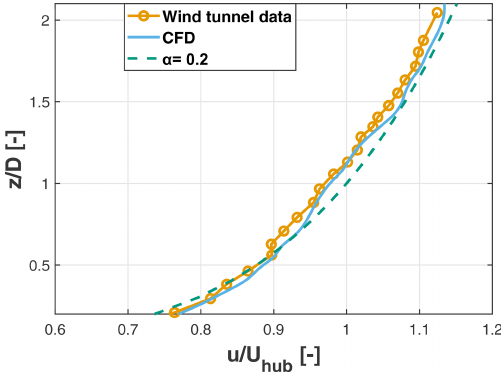
Figure 3. Measured and simulated boundary layer profiles at the turbine